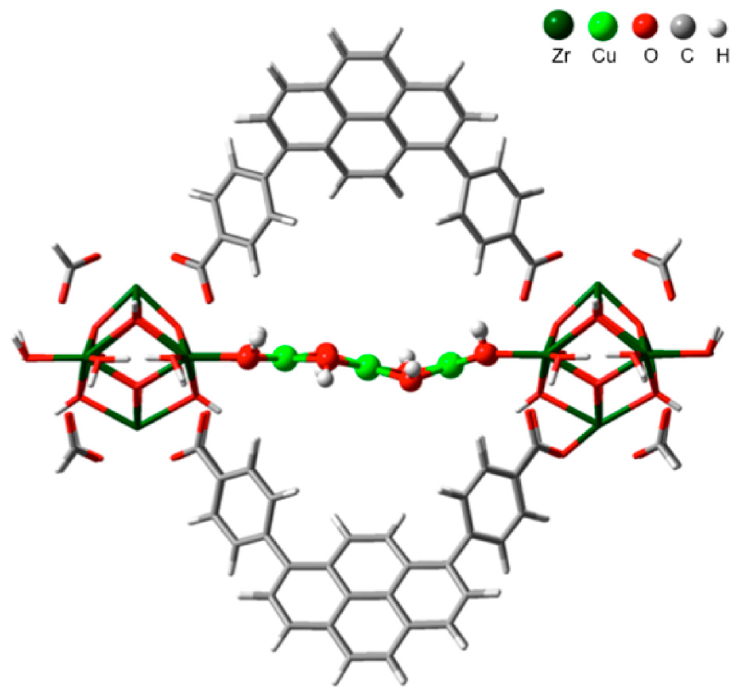
Figure 8. DFT-optimized structure of Cu-NU-1000. Reproduced with permission from ref [60]. Copyright 2017, American Chemical Society.